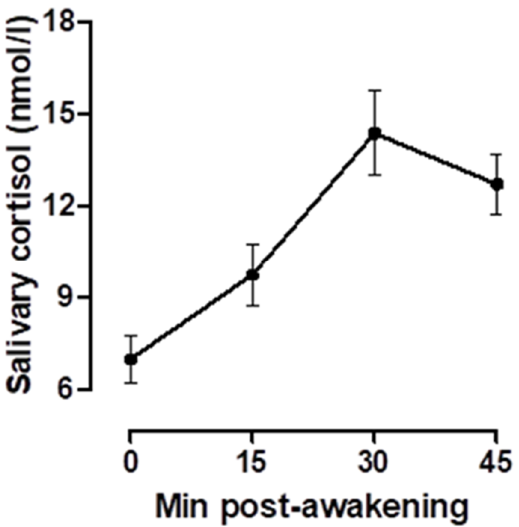
Figure 2. Mean ( ± SEM) salivary cortisol concentrations post-awakening. Figure 2. Mean (±SEM) salivary cortisol concentrations post-awakening.